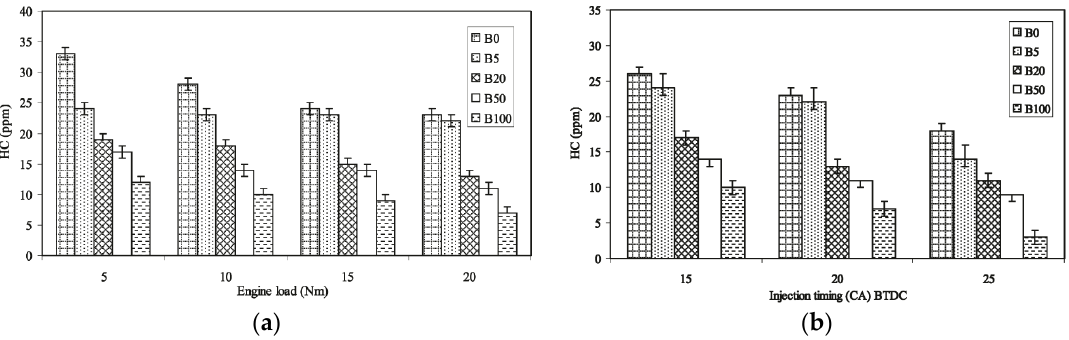
Figure 17. HC (hydrocarbon) of canola oil biodiesel blended with diesel at ( a ) various engine loads and ( b ) various injection timings (reproduced with permission from [87], American Chemical Society, 2010).